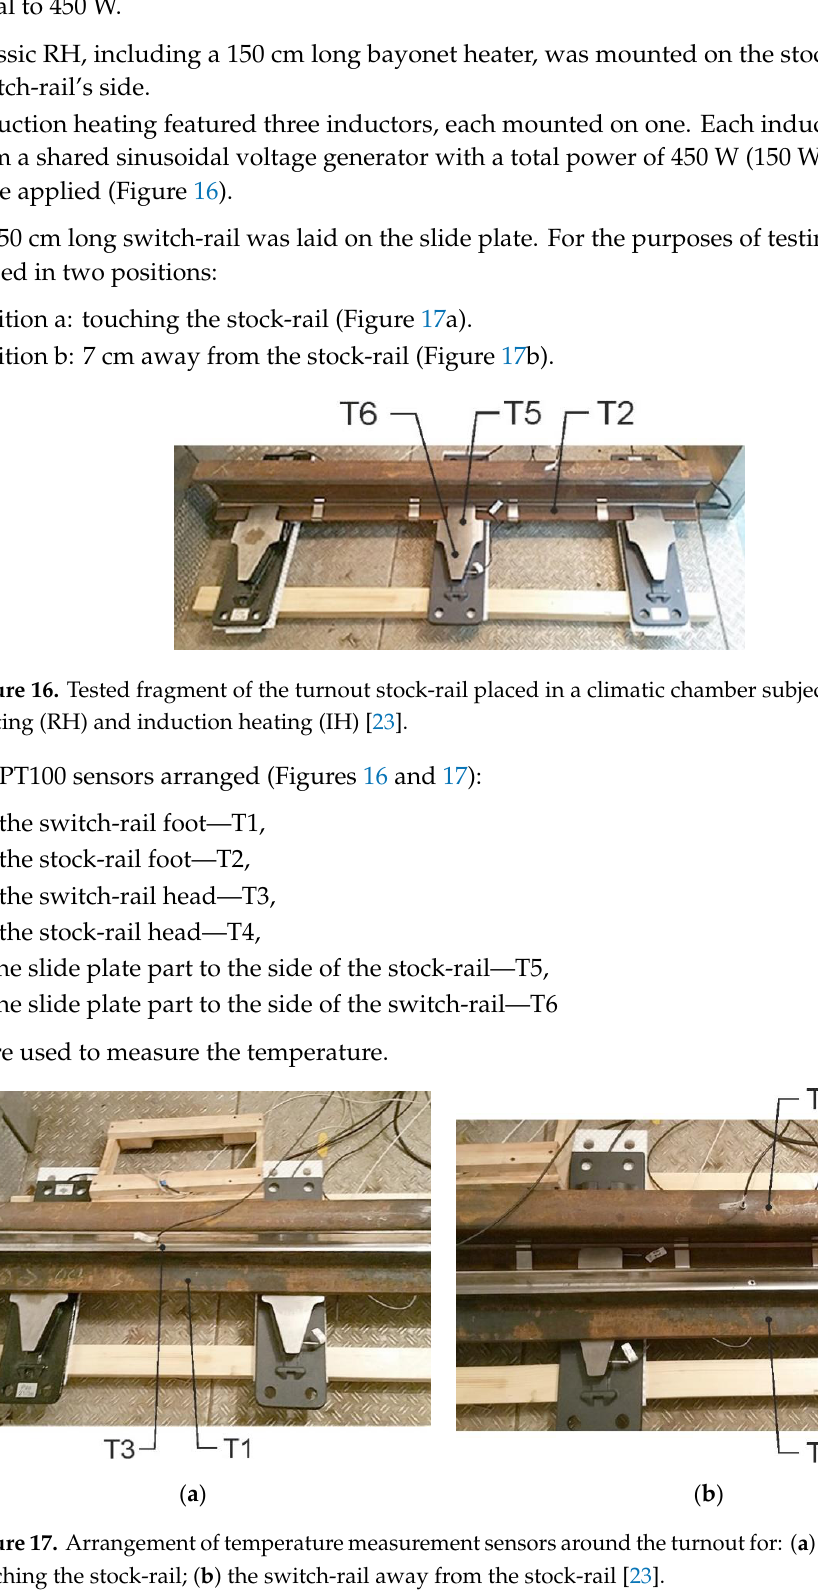
Measurement results for the ambient temperature of − 30 °C are illustrated in Figure 18. Two positions of the switch-rail in relation to the stock-rail were assumed: in contact and 7 cm away. For the switch-rail touching the stock-rail in resistance heating, maximum temperature (T1) increment